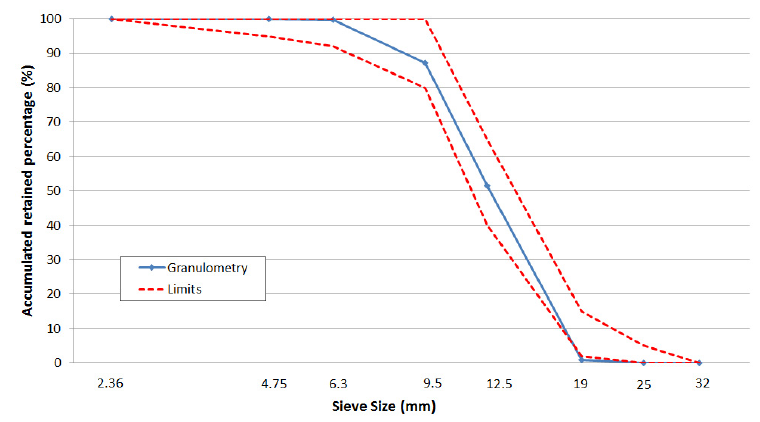
Figure 1. Particle size curve of coarse aggregate.